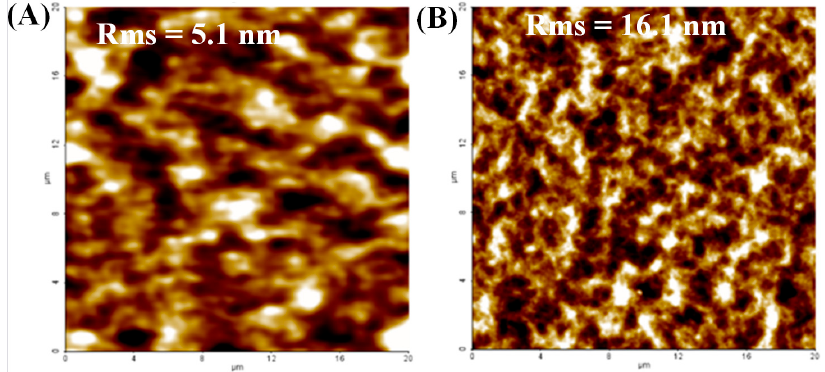
Figure 2. ( A ) Absorption spectra of (a) P3HT:IC 60 BA and (b) P3HT:IC 60 BA:DHP thin films, and ( B ) XRD patterns of (a) P3HT:IC 60 BA and (b) P3HT:IC 60 BA:DHP films.